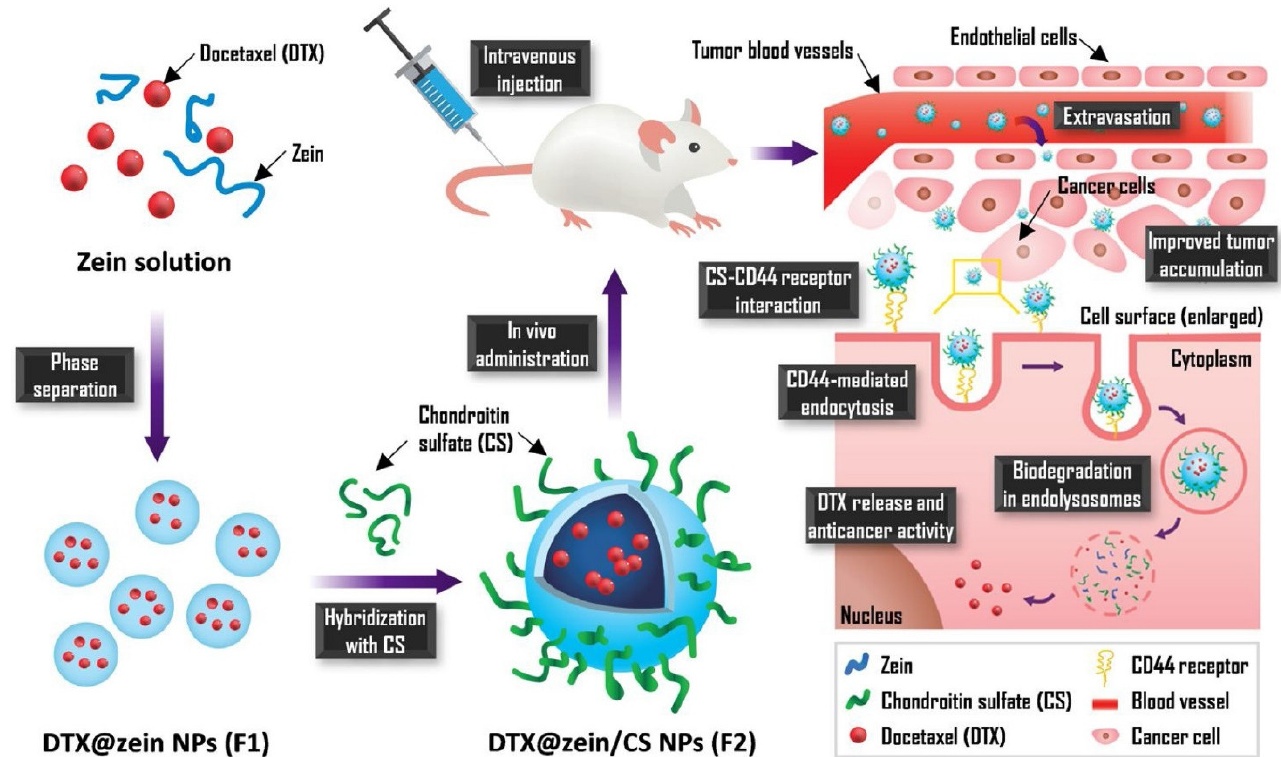
Figure 5. Scheme for the preparation Dtx-loaded CS-hybridized zein NPs and their mechanism of action. Reprinted with permission from Ref. [99]. Copyright (2021) Elsevier.